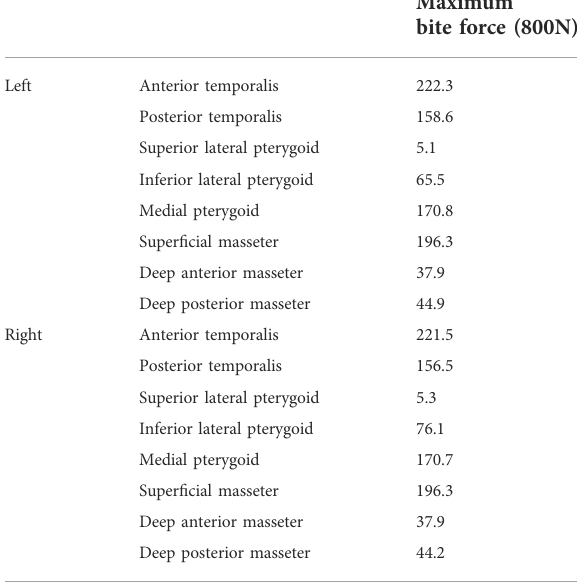
TABLE 2 Muscle force generated under maximum-force